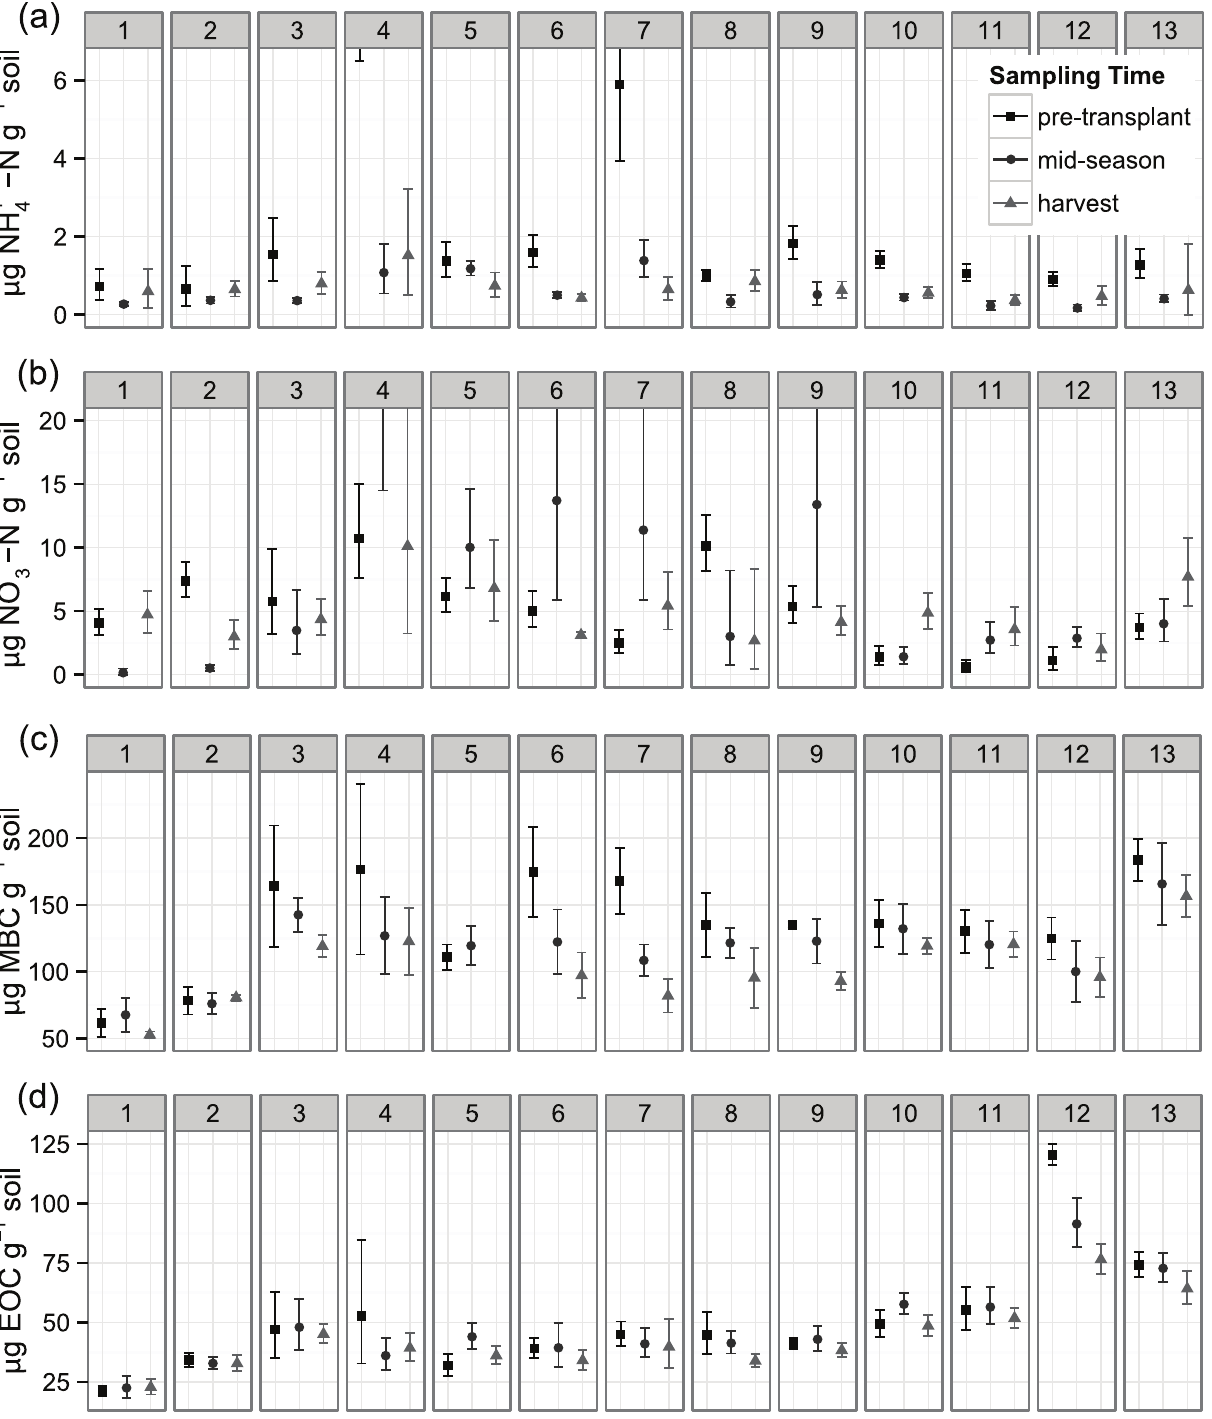
Fig 4. Soil inorganic N, microbial biomass C (MBC) and K 2 SO 4 extractable organic C (EOC) from surface soil (0 – 15 cm depth). Soils were sampled at three times across 13 organically-managed Roma-type tomato fields in Yolo Co., California, USA. For ammonium and nitrate (NH 4 + -N and NO 3 - -N), shown are back-transformed means and 95% confidence intervals. For MBC and EOC, shown are means and 95% confidence intervals. In order to increase resolution of the majority of the data, two means are not shown, both from field 4. NH 4+ -N at pre-transplant in field 4 was 30.5 μ g N g -1 (6.5 < μ < 131.8) and NO 3- -N at mid-season in field 4 was 35.0 μ g N g -1 (14.5 < μ < 82.7).